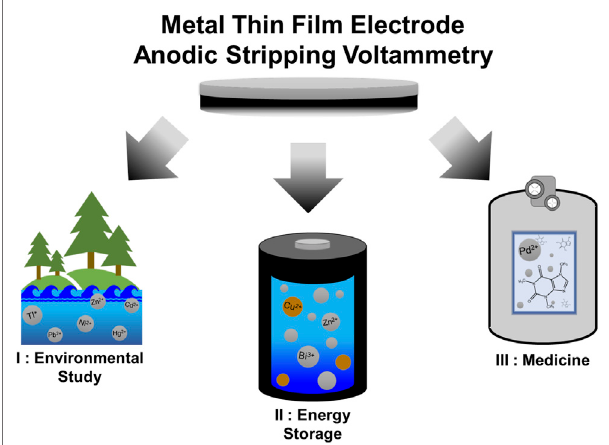
FIGURE 1 | Overview of the applications of MTFE-based ASV analysis, including I) identi fi cation and quanti fi cation of toxic metals in the environment, II) quanti fi cation of metal species in alkaline battery systems, and III) detection of catalysts and other metals in medically important systems.